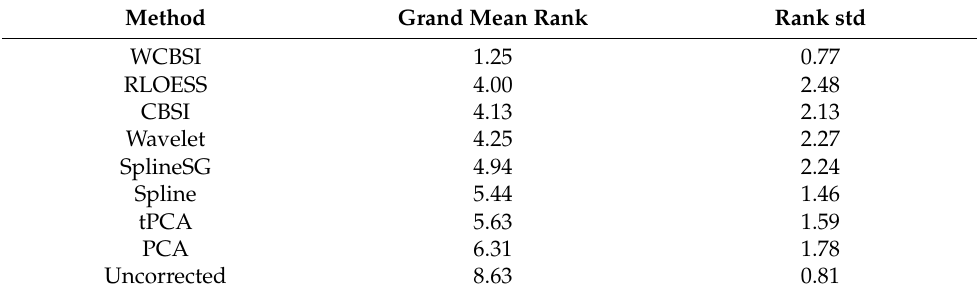
Table 2. Correction methods sorted by mean rank.